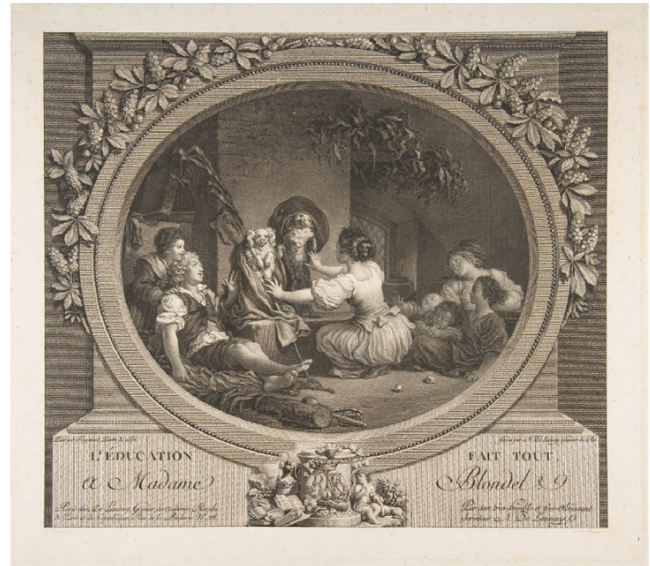
Figure 13. Nicolas de Launay after Jean Honoré Fragonard, L’Education Fait Tout, 1790, Etching and Engraving, 26.9 cm × 30.6 cm, Metropolitan Museum of Art, New-York, Purchase, Roland L. Redmond Gift, Louis V. Bell and Rogers Funds 1972; 1972.539.16.